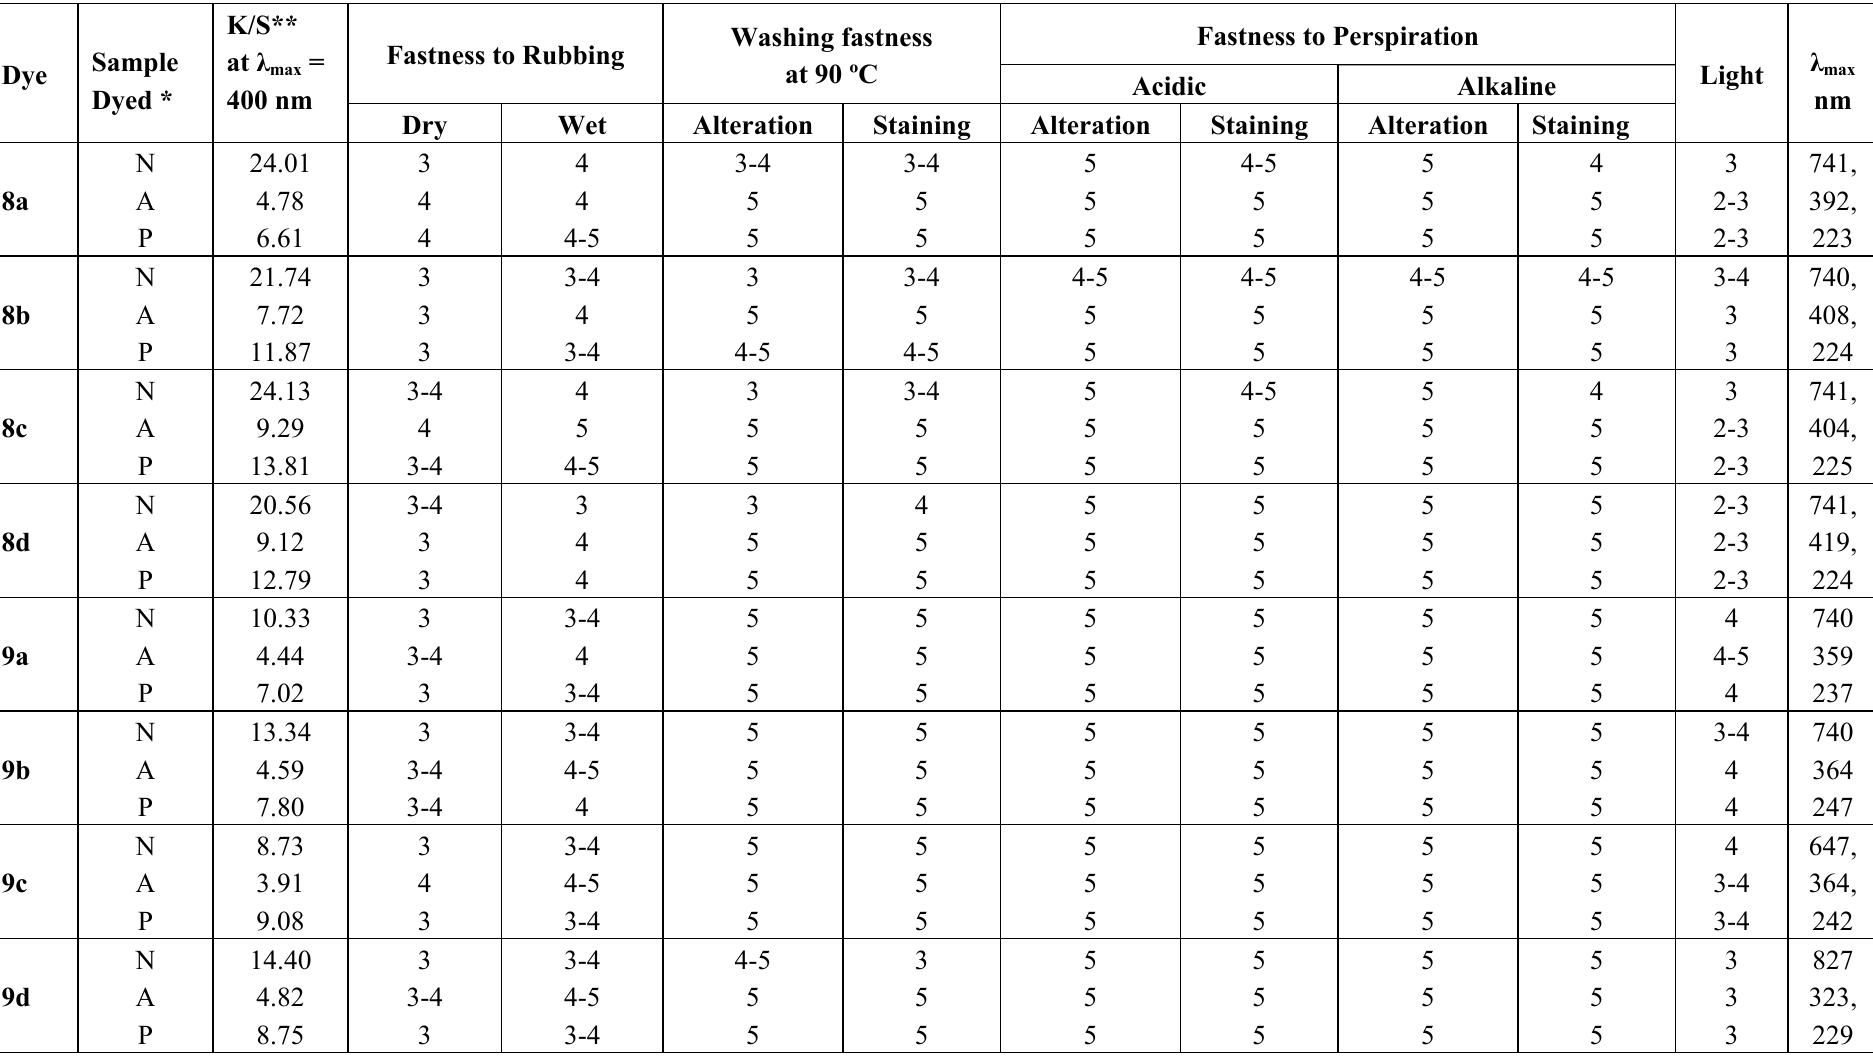
Table 1. Fastness properties of disperse dyes on different